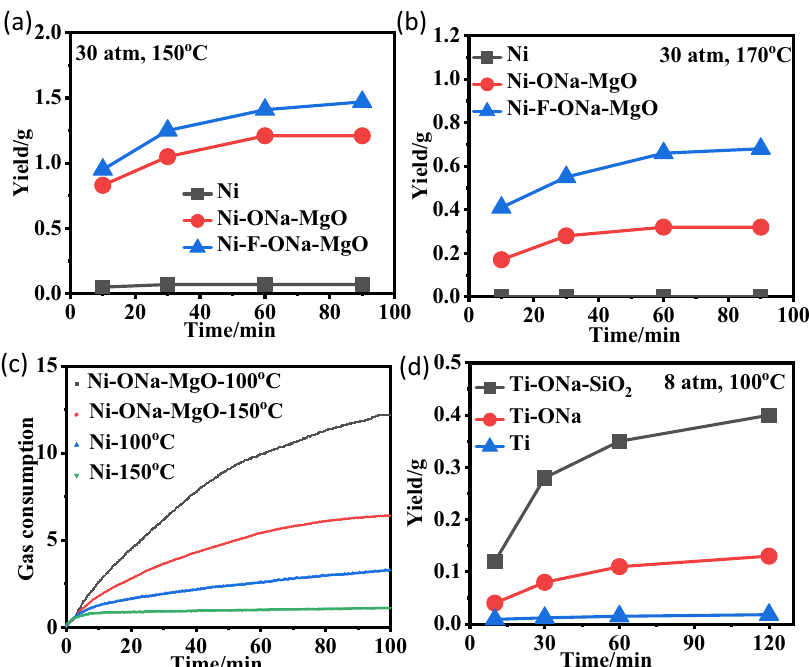
Fig. 3 Polymerization at high temperatures. a , b Time-dependence studies (yield versus time) of the nickel catalysts at 150 °C (0.1 µ mol) and 170 °C (0.25 µ mol), 30 atm. c Real-time ethylene consumption detection curve for polymerization of the nickel catalysts (0.1 µ mol) at 150 °C and 100 °C, 30 atm. d Time-dependence studies (yield versus time) of the titanium catalysts (0.5 µ mol) at 100 °C, 8 atm.